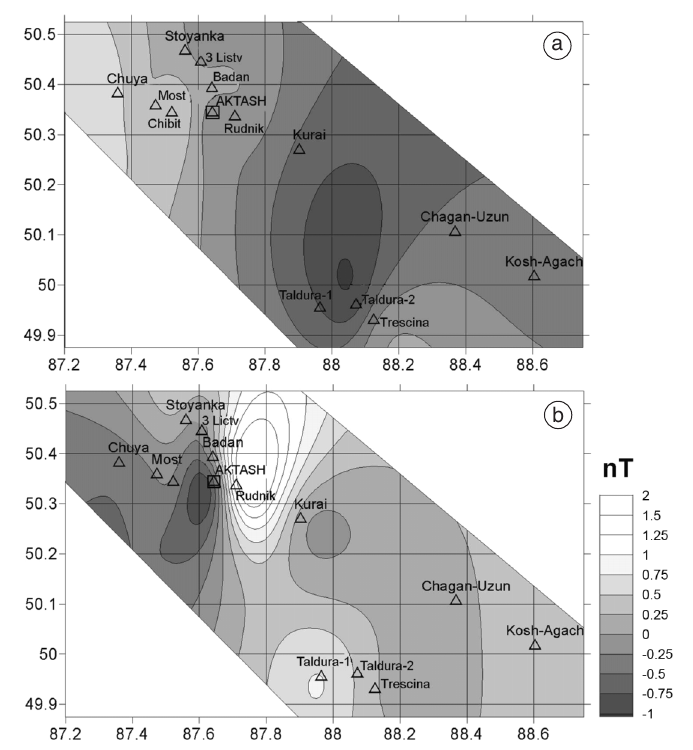
Fig. 2a,b. Total field variations in the epicenter of the main shock of 27/09/2003 a) from early October to late November 2003 and b) from late November 2003 to late May 2004. Triangles show repeated-survey sites and boxed triangle shows the continuous